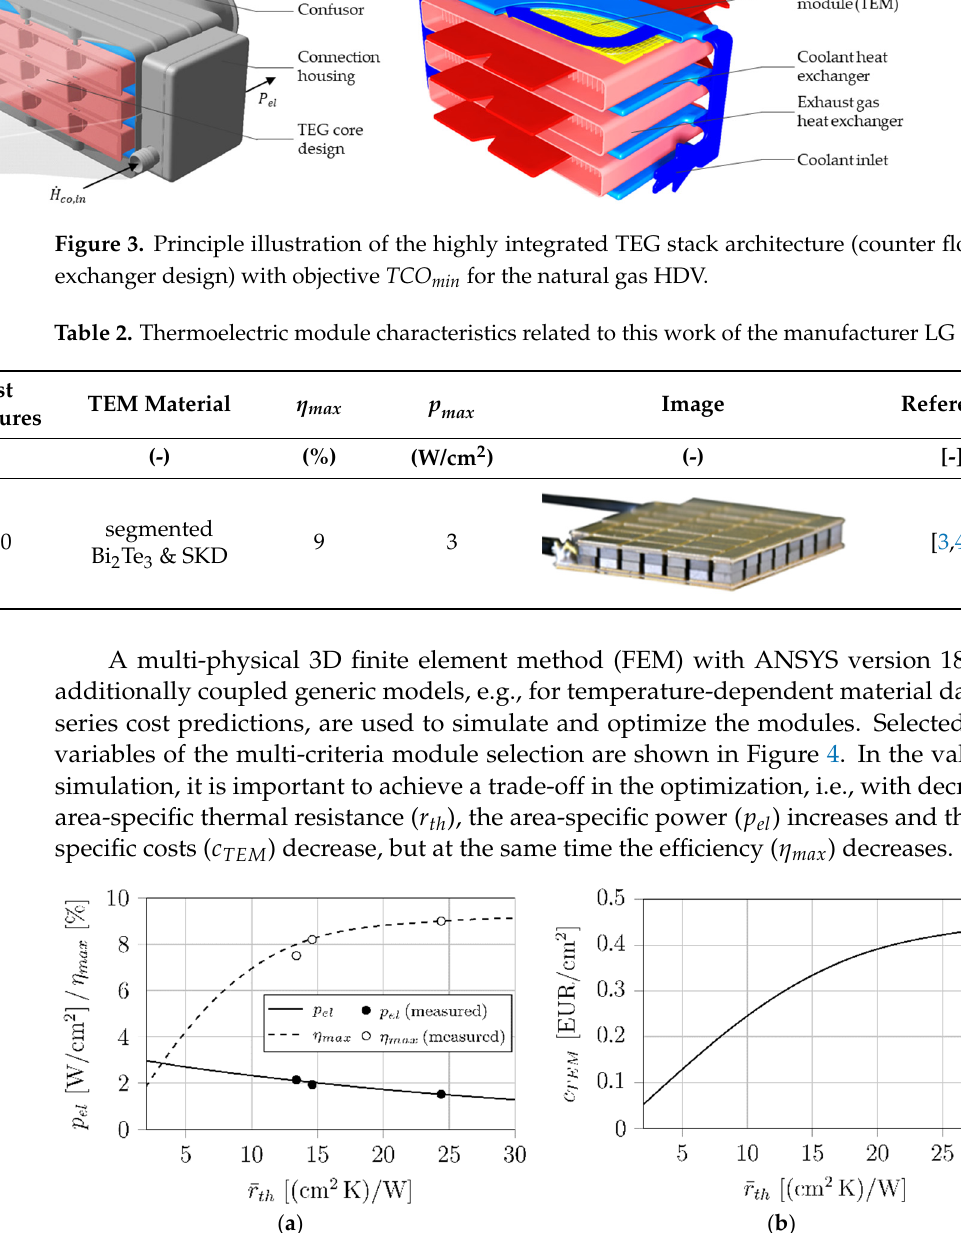
Figure 4. Multi-criteria design and optimization of segmented high temperature modules. ( a ) Area- specific power density and efficiency. ( b ) Area-specific costs.